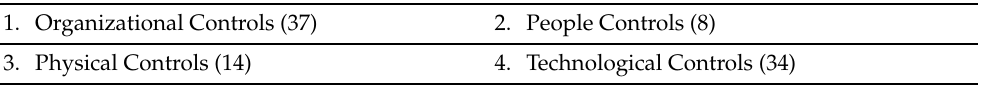
Table 1. Domains of ISO 27001 and distribution of 93 security controls in each